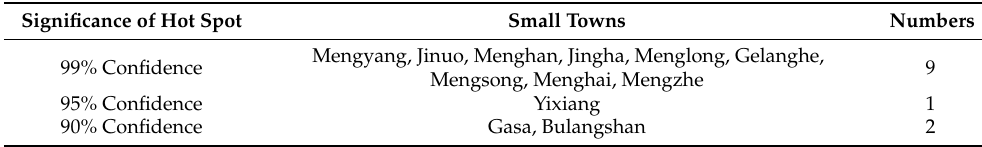
Table 9. Cluster results of resource potential dimension.